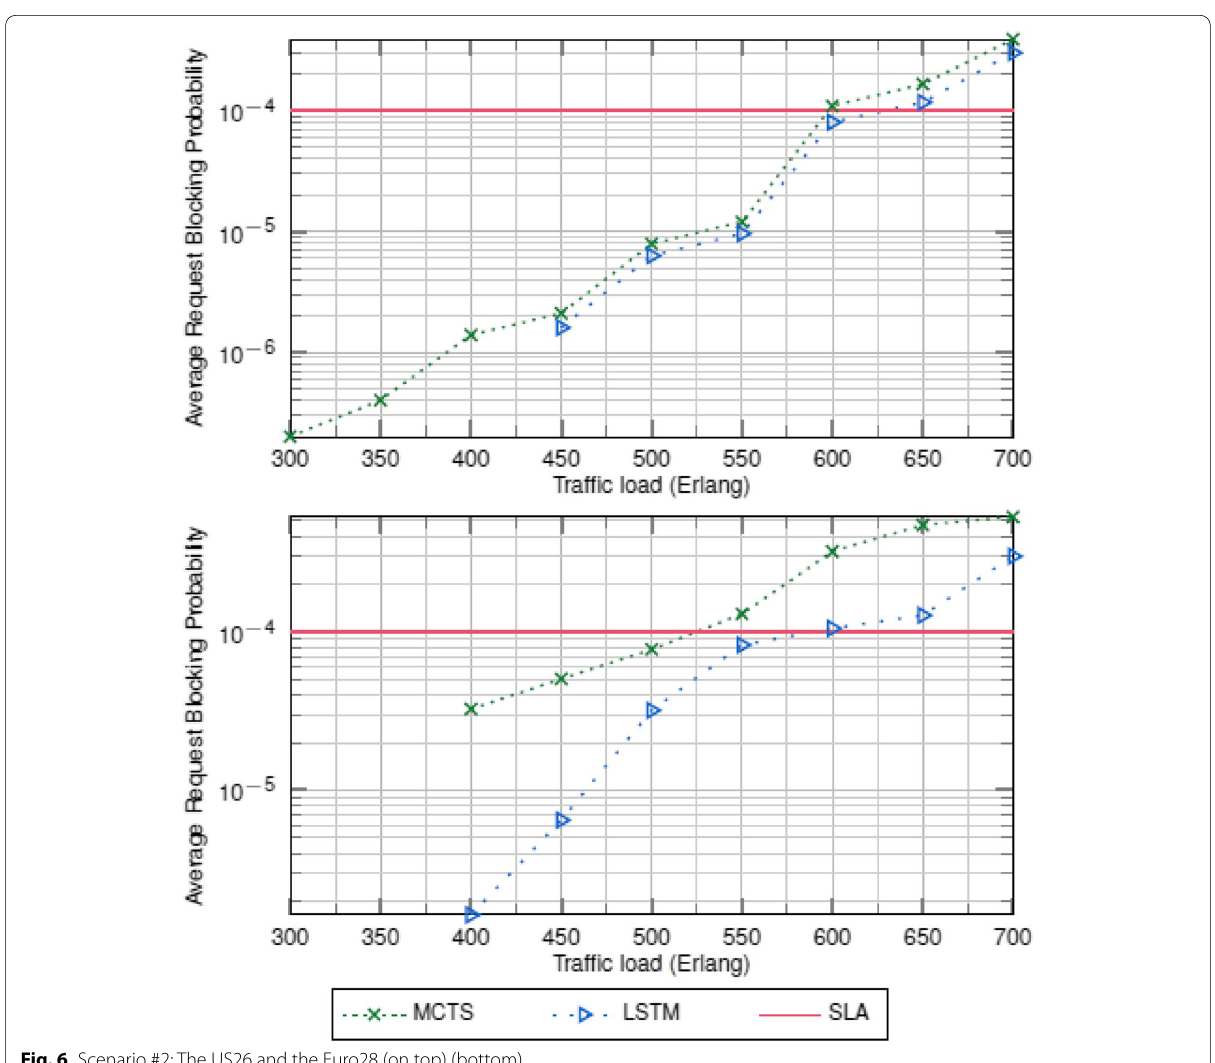
Fig. 6 Scenario #2: The US26 and the Euro28 (on top) (bottom)